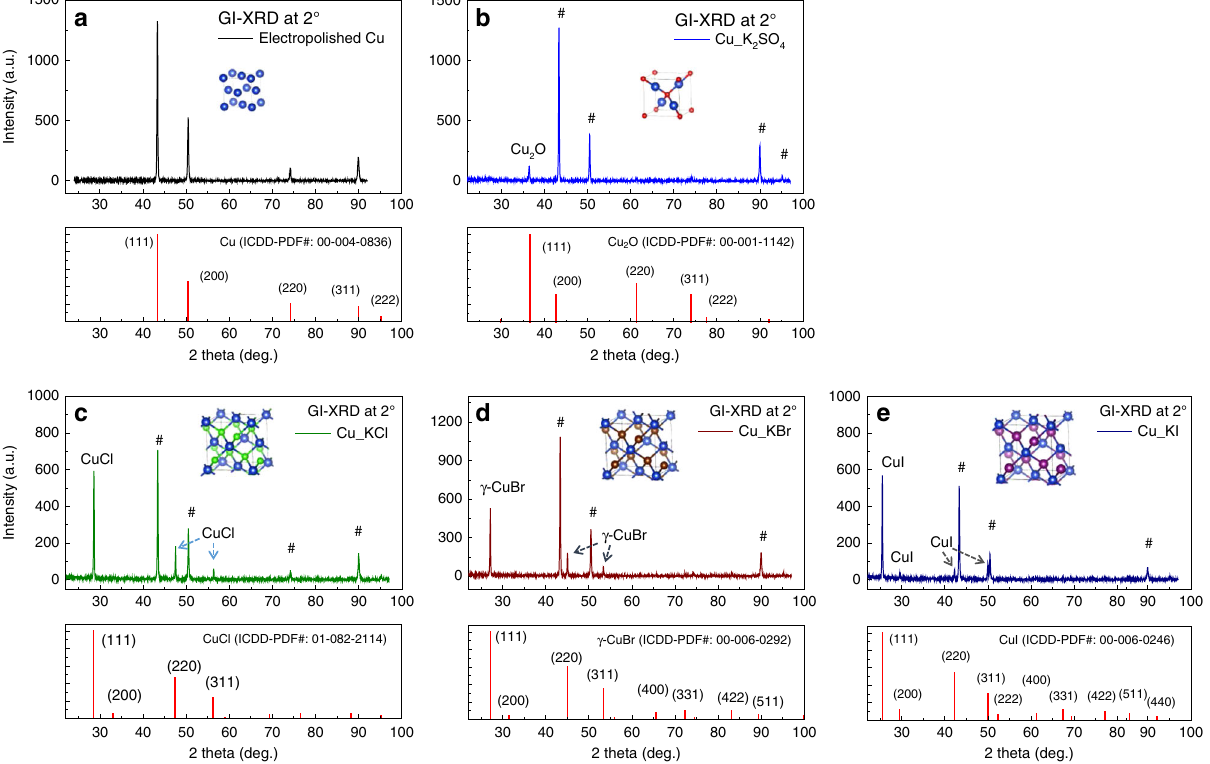
Fig. 2 Crystal structures of halogenated Cu identi fi ed by grazing incident X-ray diffraction. GI-XRD patterns of the original electropolished Cu foil ( a ). Cu foils oxidized in 0.05 M K 2 SO 4 at 1.1 V vs. Ag/AgCl for 300 s (control sample) ( b ), or halogenated in KCl ( c ), in KBr ( d ), and in KI ( e ) for 100, 60, and 30 s, respectively. The symbol # indicates peaks corresponding to the underlying Cu-foil substrate. The incidence angle used for GI-XRD was 2°. The inset of each GI-XRD plot is a diagram of the unit cell for Cu, Cu 2 O, CuCl, CuBr, and CuI, from ( a ) to ( e ), respectively. Cu atoms are represented as blue spheres. Source data are provided as a Source data fi